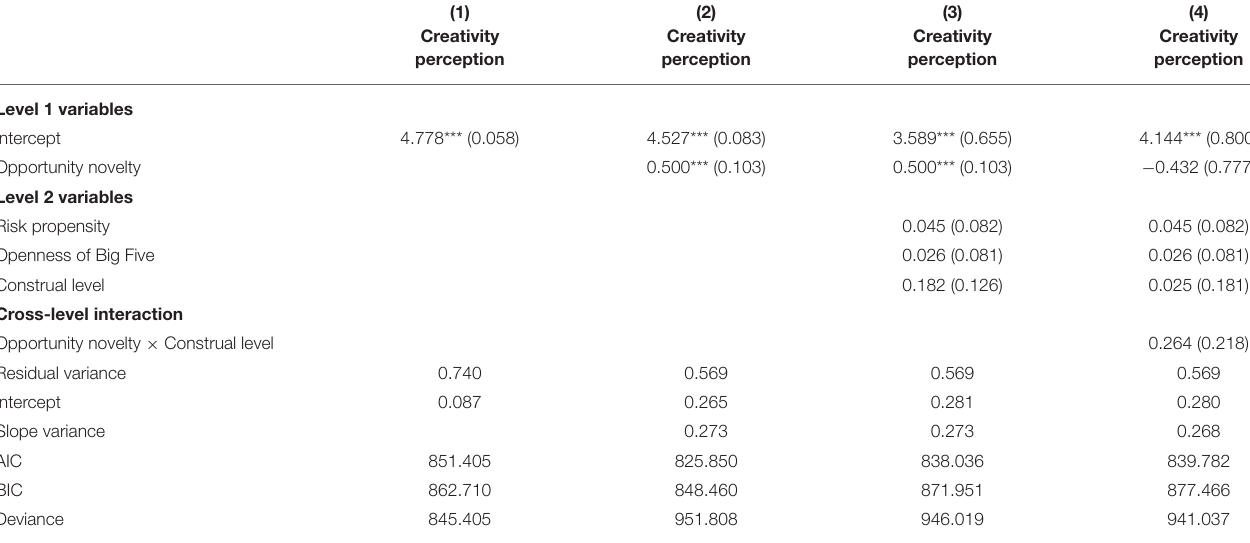
TABLE 2 | HLM results for the interactive effect of opportunity novelty and construal level on creativity